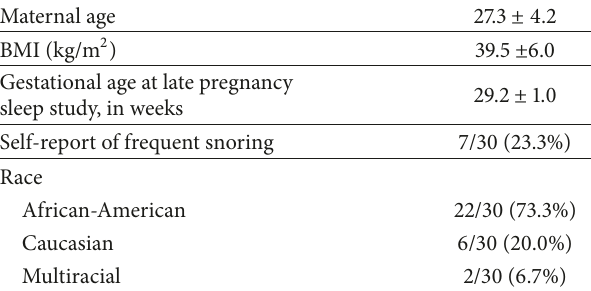
Table 1: Participant